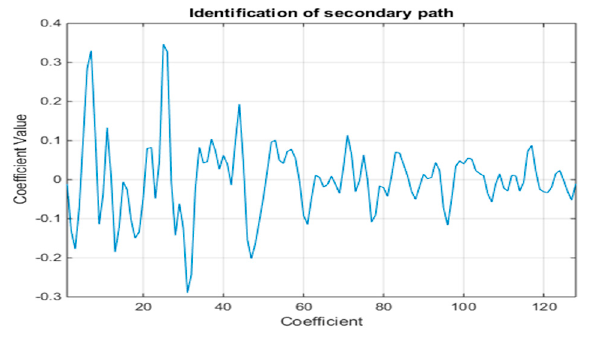
 2 ( ) p P n ; ( c ) identifi-